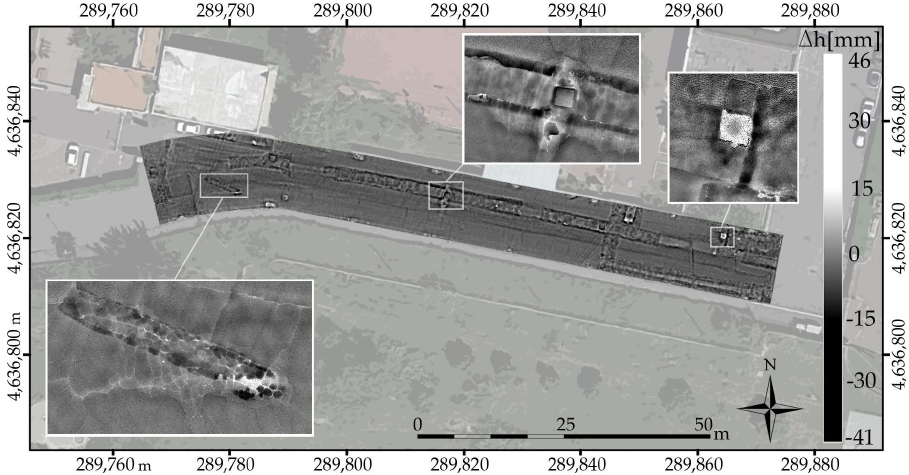
Figure 12. Roughness values given in grey-scale tones. The graduation ranges from black (negative values) to white (positive).